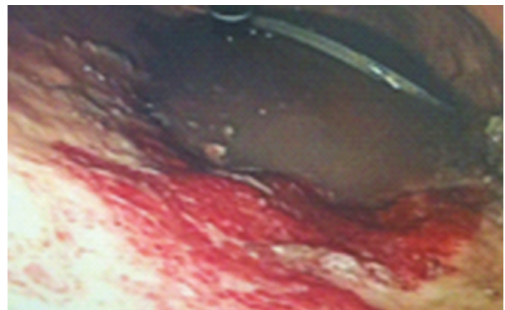
Figure 2: Upper GI endoscopy: showing oedamatous beefy red mucosa along the greater curvature of stomach.